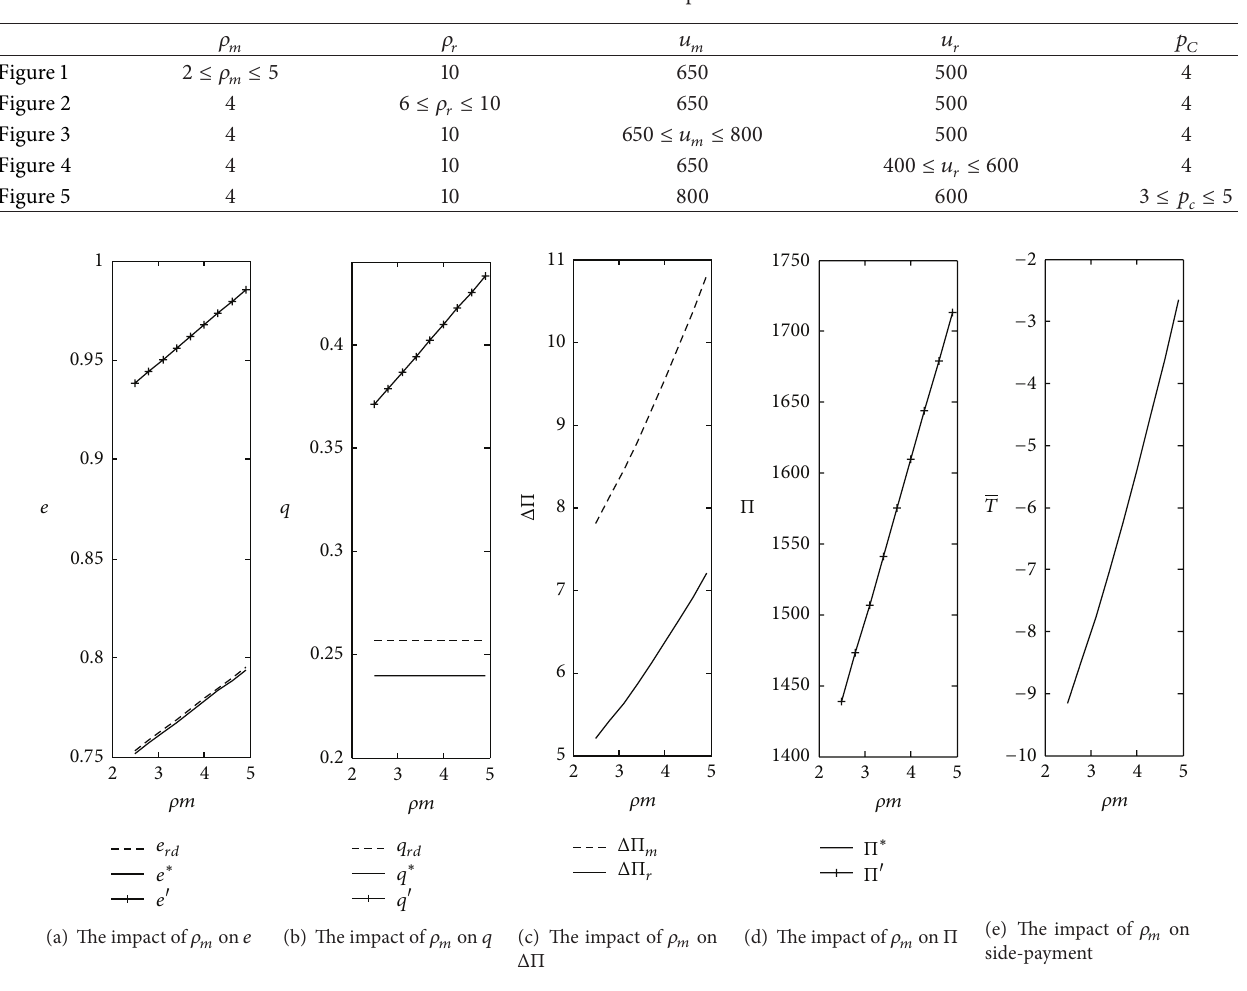
Figure 1: The impact of 𝜌 𝑚 on decision variables and